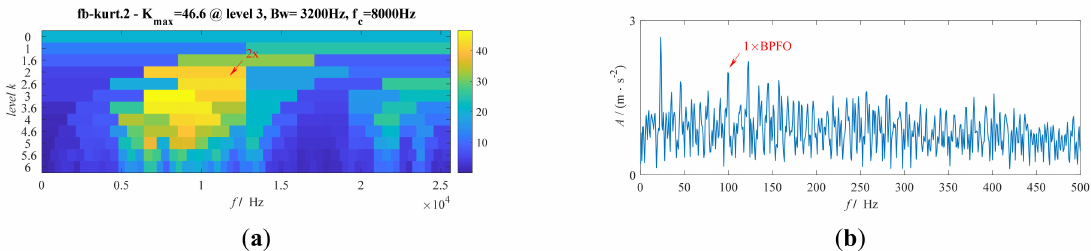
Figure 16. Results by FK for the signal from the Curtin University: ( a ) Kurtogram and ( b ) SES.